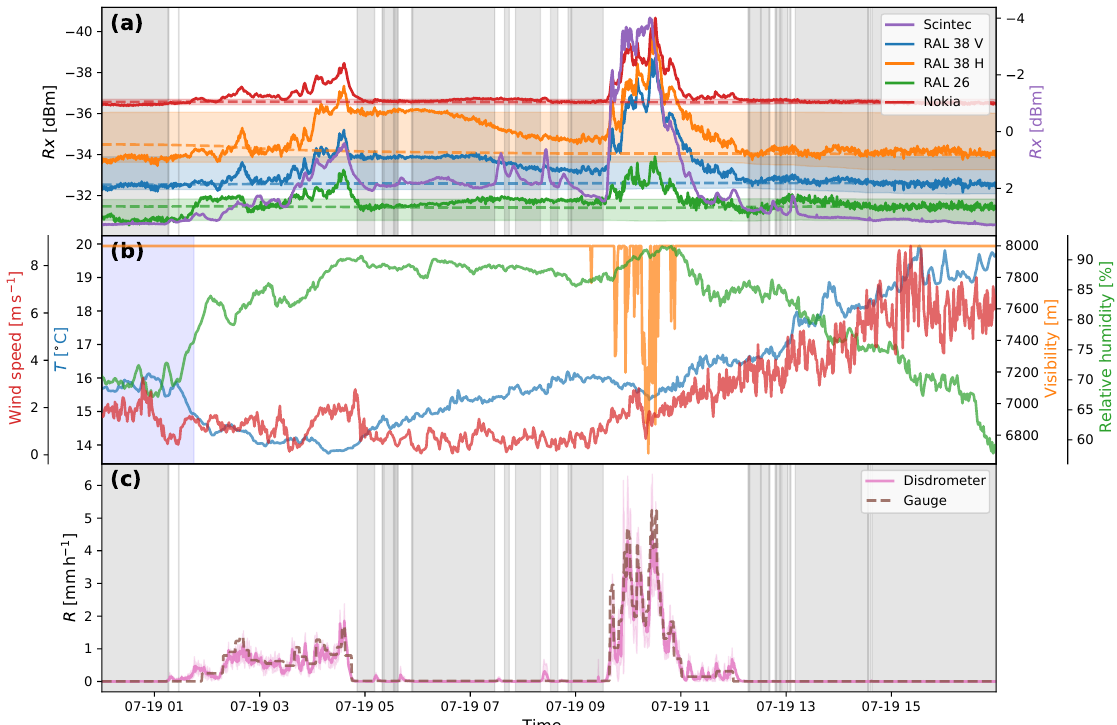
Figure 16. Time series of an event on 19 July 2015. (a) Received power levels at the detectors (solid lines) and reference levels (median over dry periods in a 24h moving window: dashed lines). The 5th and 95th percentile power levels over dry periods in a 24h moving window are indicated by the coloured shading. (b) Several atmospheric variables measured at the “Veenkampen” meteorological station: relative humidity, visibility, and ambient air temperature at 2m, and wind speed indicated with blue, orange, green, and red lines, respectively. Periods with a negative net radiation flux at the surface are indicated with blue shading. (c) The spatial weighted average rainfall intensities derived from the disdrometers are indicated by the pink line, with the weighted standard deviation among the disdrometers displayed by the pink shaded area. The rainfall intensities derived from the tipping bucket gauge are indicated with the dashed line. Dry periods, as indicated by the disdrometers, are displayed by grey shaded